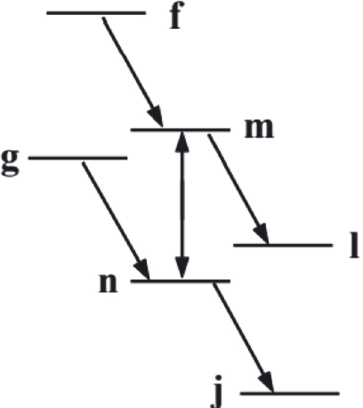
Figure 1: Level diagram for two monochromatic fields interacting with an atom. One strong field is resonant with the m − n transition; the other field probes the adjacent transition. Diagram reproduced from